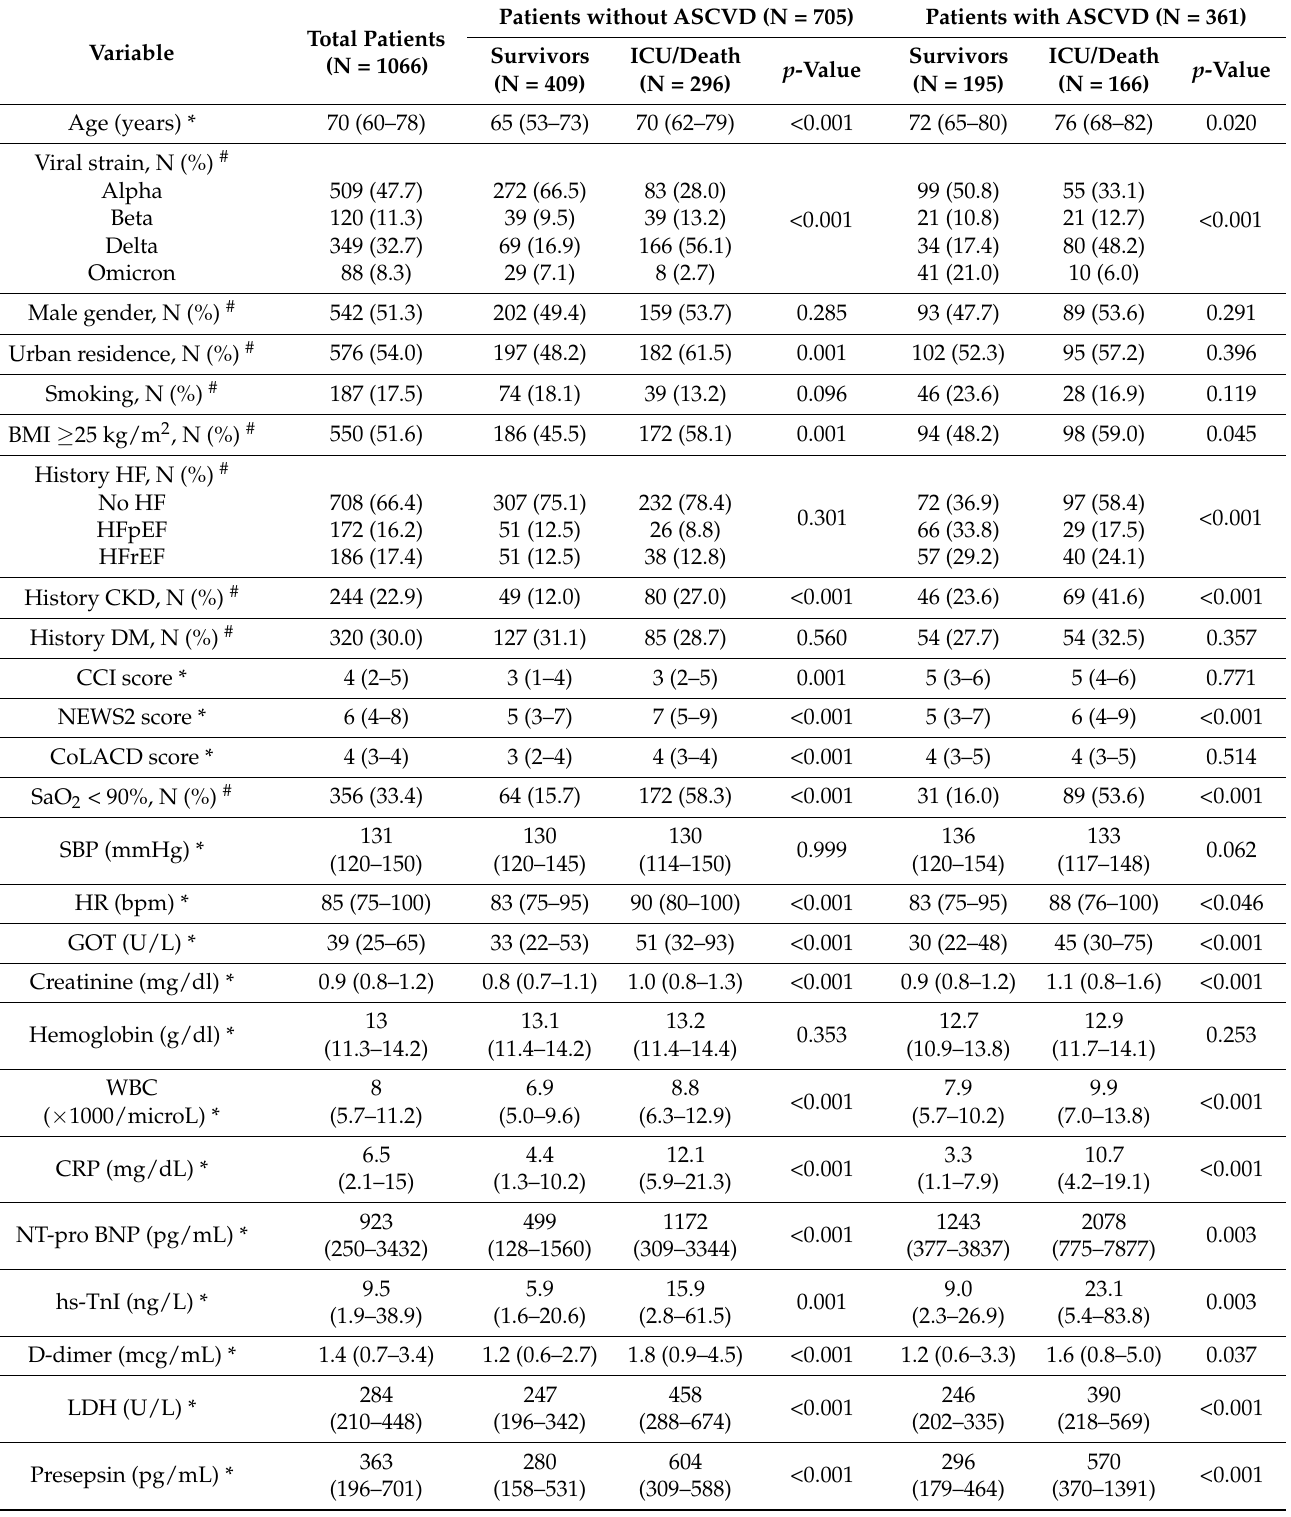
Table 1. Demographic, clinical and laboratory characteristics upon admission in all patients, and by history of Atherosclerotic Cardiovascular Disease (ASCVD) and composite